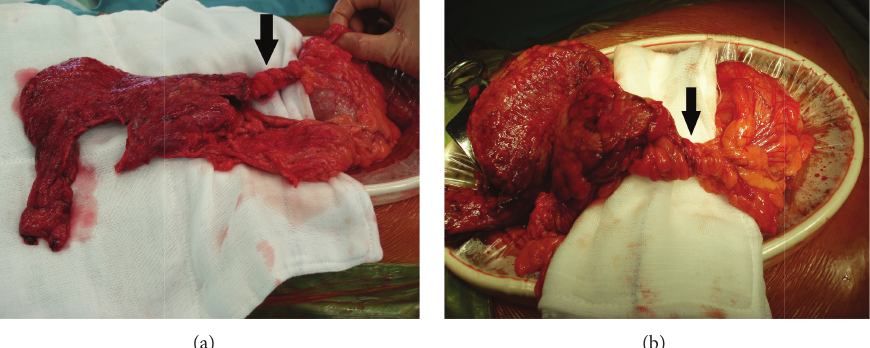
Figure 2: Intraoperative findings. (a) The right part of the greater omentum has twisted four times in a counterclockwise direction (arrow). (b) The distal part of the omentum is